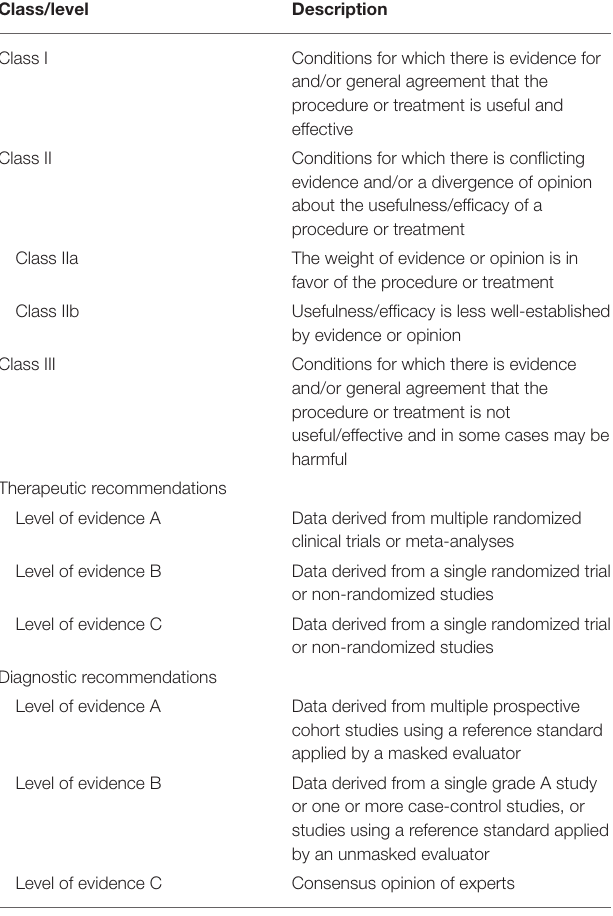
TABLE 2 | Definition of classes and level of evidence used in recommendations.